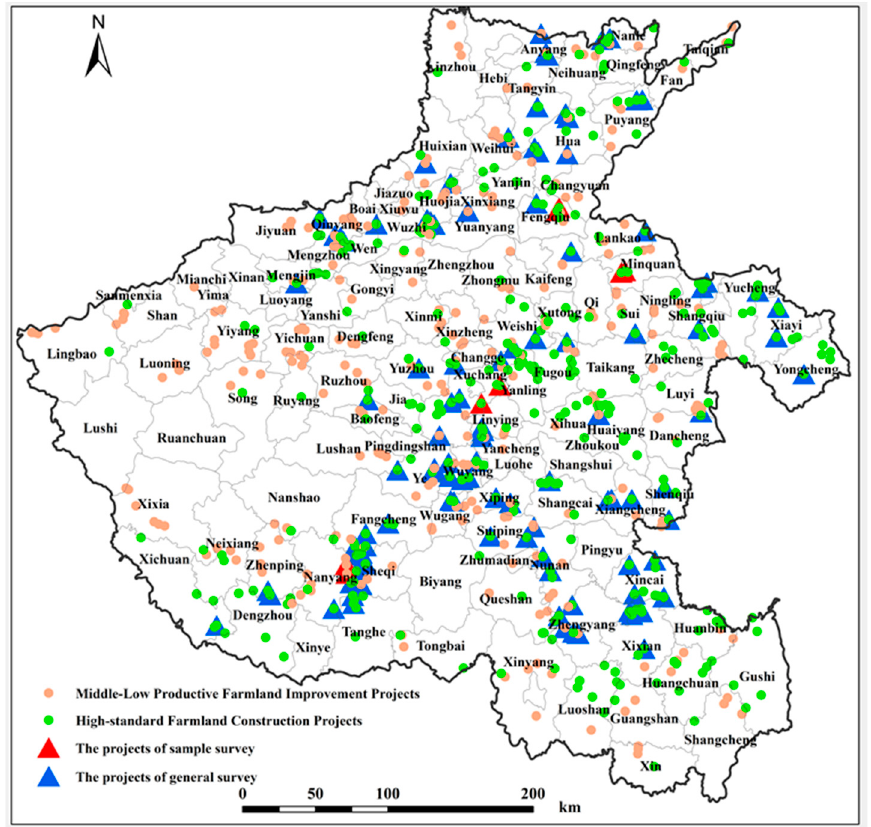
Figure 1. Spatial distribution of the MLPF transformation project regions and HSF construction project regions in Henan Province, and general survey projects and sample survey projects in this study. NOTE: For the definition of the general survey projects and the sample survey projects refers to Section 2.3.1.